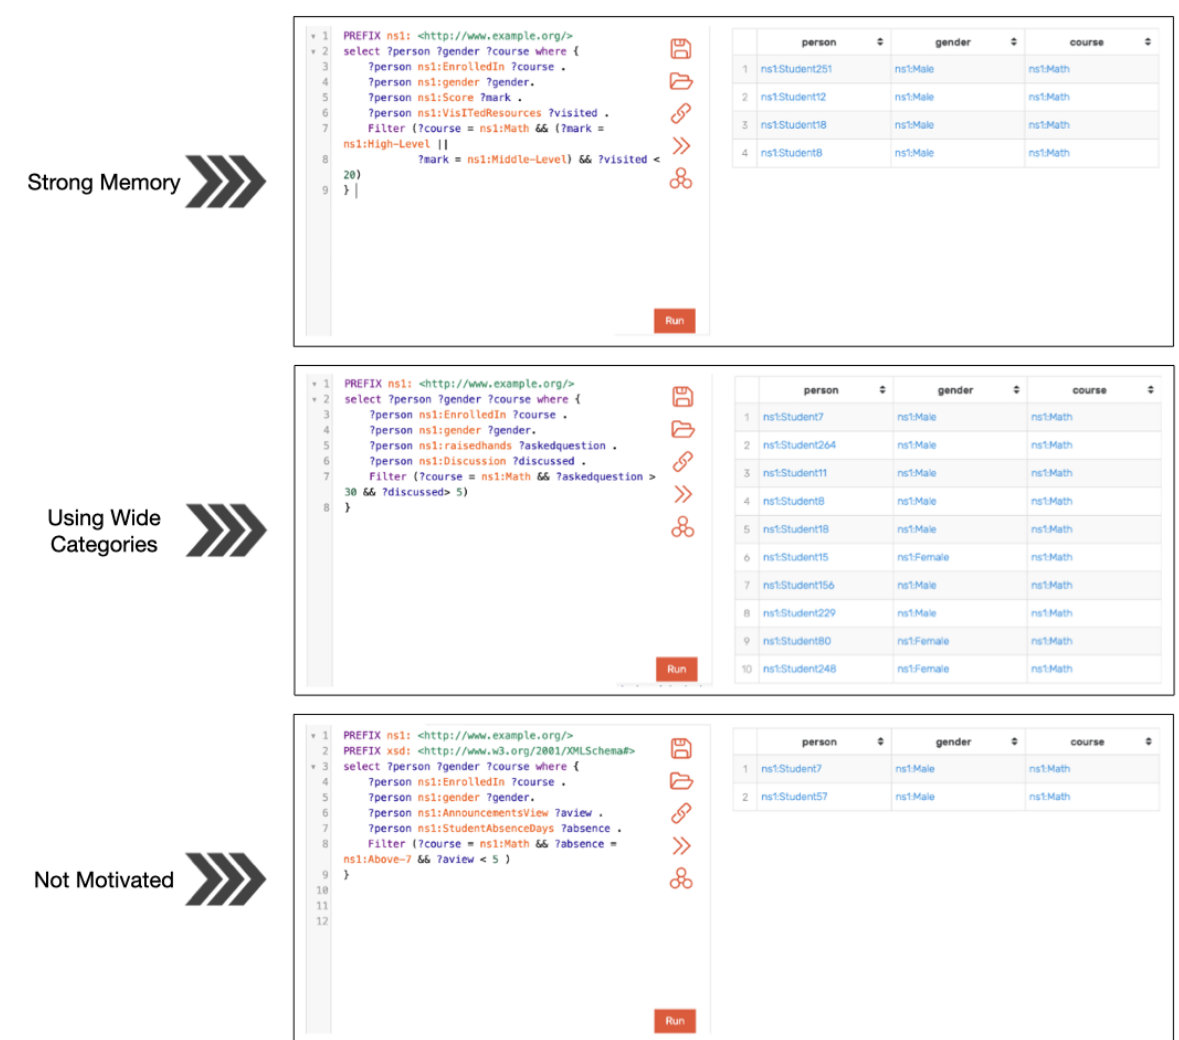
Figure 7. The SPARQL queries and their results for finding students with three creativity patterns: Strong Memory, Using Wide Categories, and Motivation